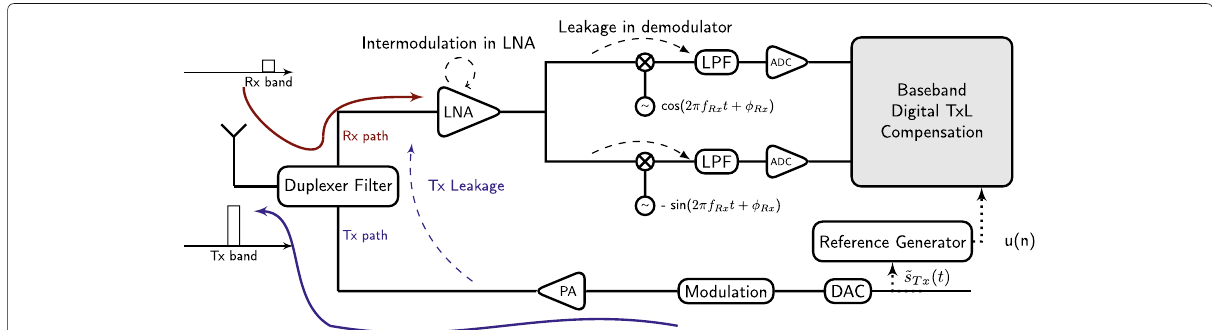
Fig. 1 Transceiver scheme. Classical frequency division duplexing chain in a RF transceiver with Tx leakage baseband pollution. The PA denotes the power amplifier, the ADC is the analog to digital converter, and the DAC denotes the digital to analog